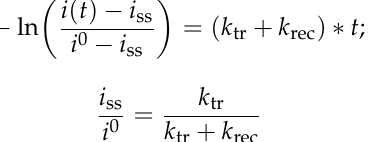
Figure 6. Potentiostatic photocurrent transients registered during the illumination periods for the LFO ( a ), LFO/Pt ( b ) and LFO/TiO 2 (1:100) ( c ) electrodes at potentials of 0.850, 0.750, 0.550, 0.350 V vs. RHE in deaerated 0.1 M NaOH solution.